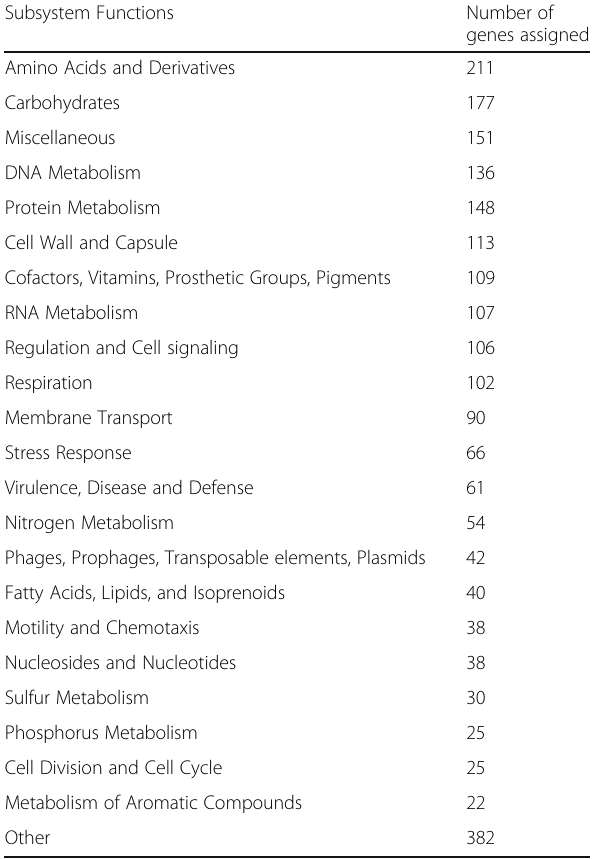
Table 1 The number of genes assigned to functional subsystems using